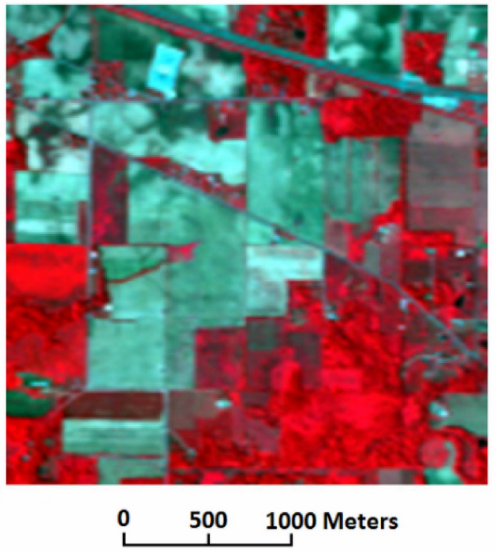
Figure 1. The image of Indian Pines